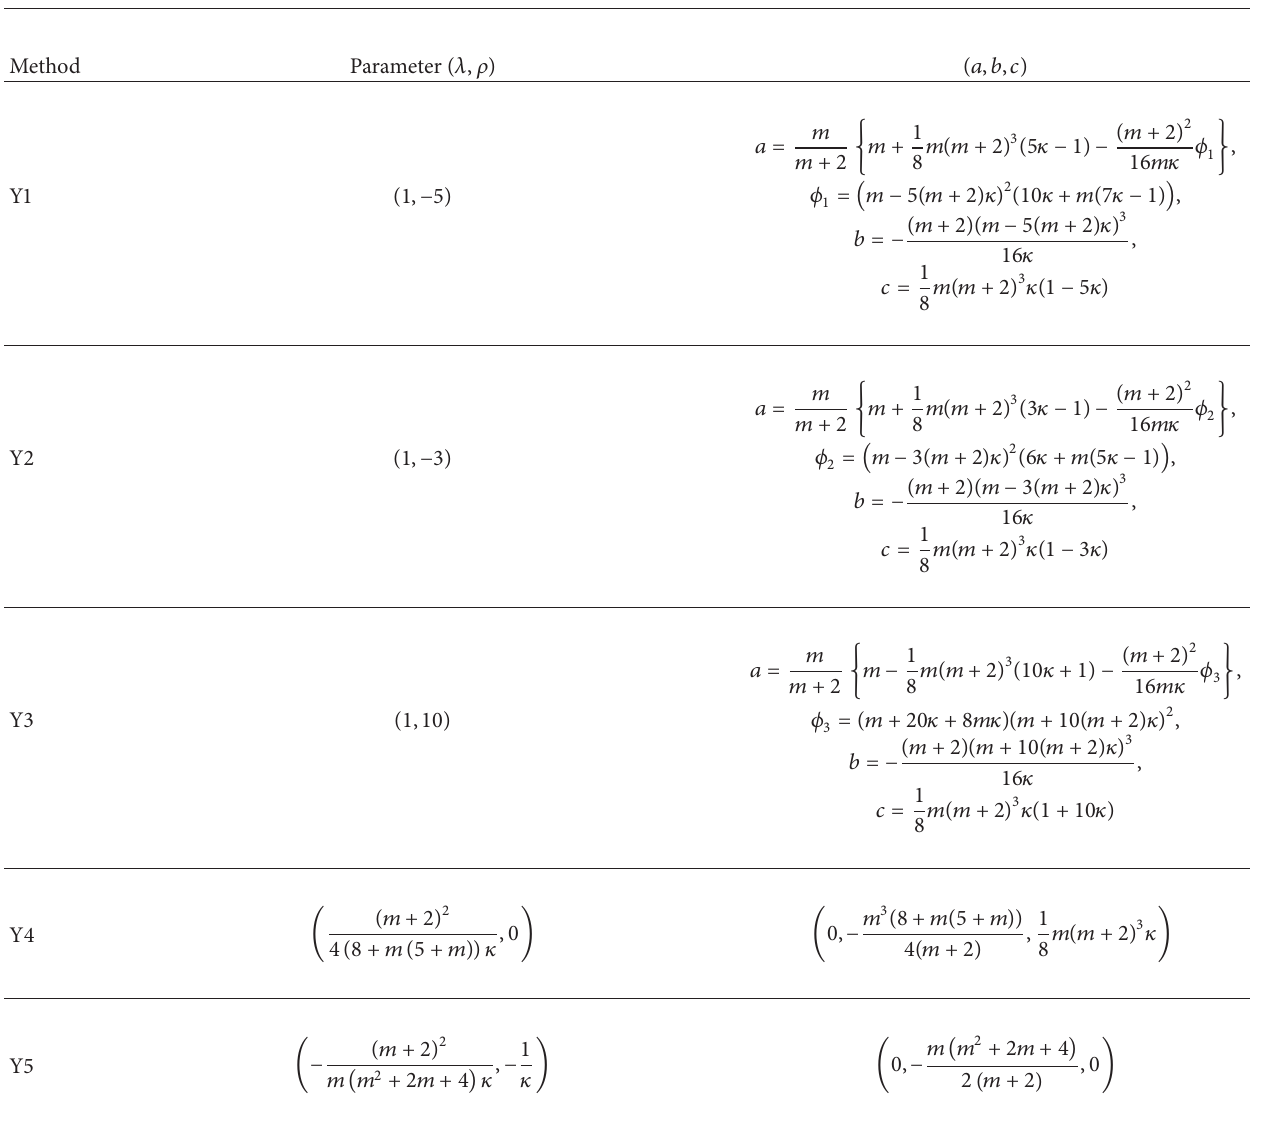
Table 1: Various methods with typical choice of parameters (𝜆,𝜌,𝑎,𝑏, and 𝑐)